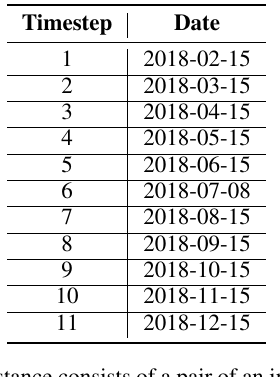
Table 1. Span of the L3A tile time series.